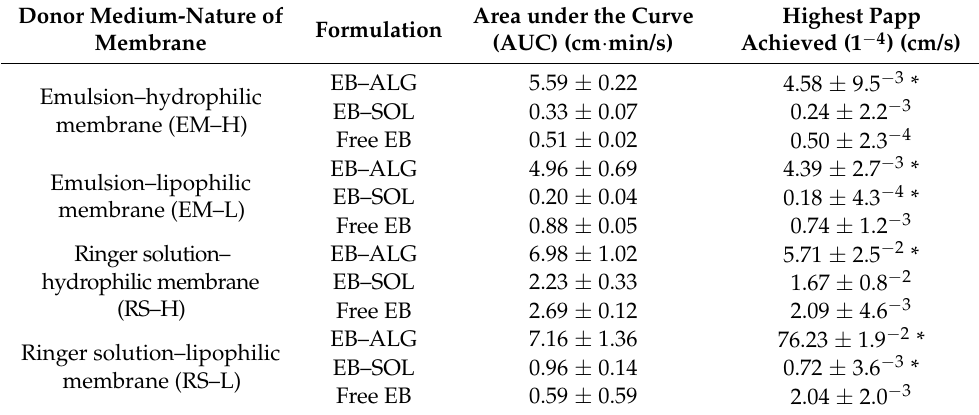
Table 1. Apparent permeability results of synthetic membrane.